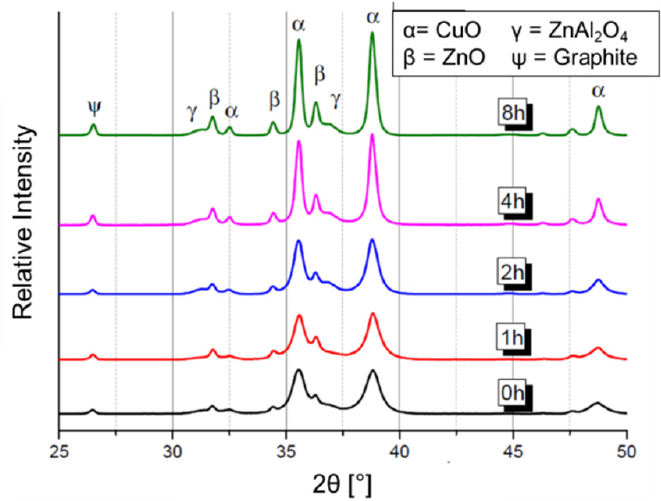
Figure 13. PXRD patterns depending on the duration of the calcination. Catalyst system: Cu 0.61 Zn 0.21 Al 0.18 , h equ = 600, T calc = 823 K, heating rate = 1 K ∙ min − 1 . Based on the diffractograms shown in Figure 13, the crystallite copper oxide crystallite sizes were calculated (Figure 14). An almost linear increase in the CuO crystallite sizes with enhanced calcination time can be observed. Therefore, the calcination temperature and the time influence the thermally induced conversion processes within the catalyst.